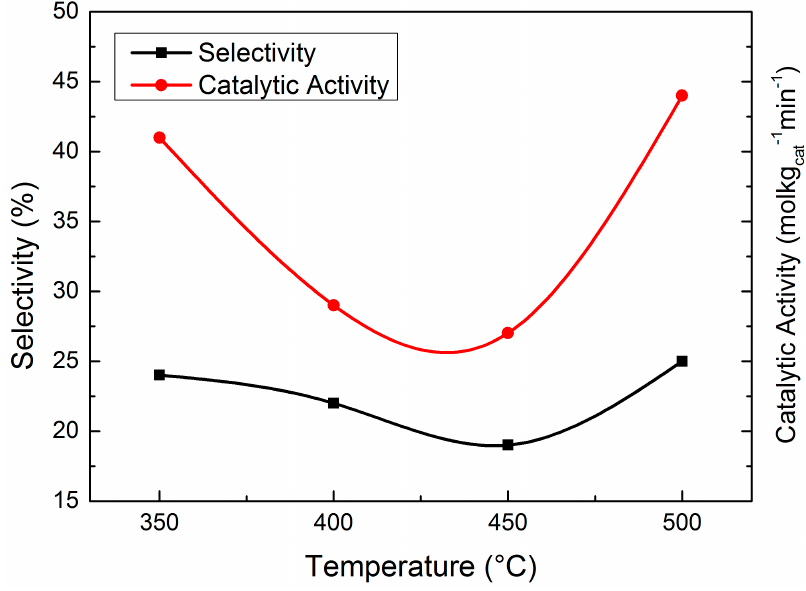
Figure 8. Evaluation result of catalysts reduced at different temperatures.